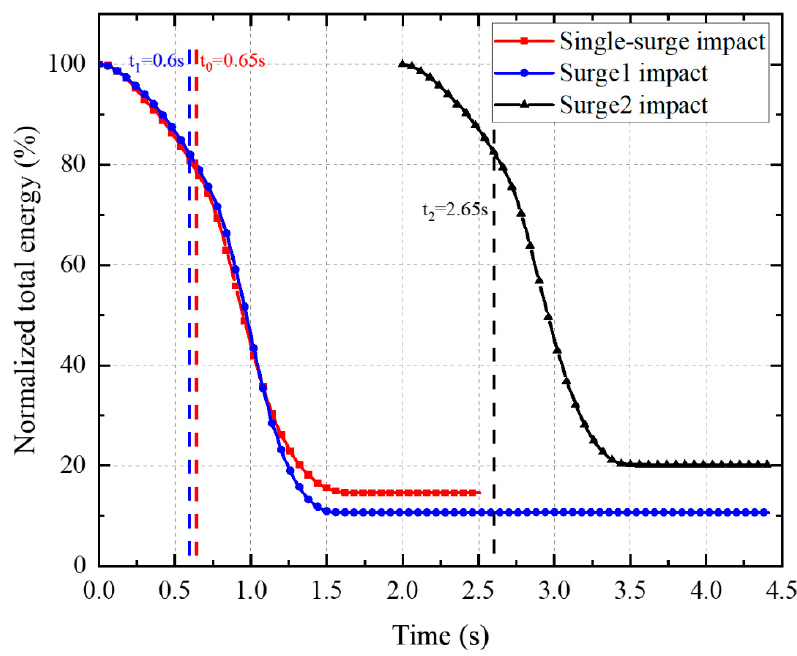
and penetration at the interaction face between surge2 and the dead zone ( 𝐸 ∆(cid:3020)(cid:2869)(cid:2879)(cid:2870) ) account for 1.94%. Figure 7. Normalized total energy of the debris surge with a slope angle of 40 ◦ and surge volume of 39.6 L. The vertical dashed lines mark critical times of the flow front. t 0 and t 1 are the time the flow fronts reach the barrier, while t 2 is the time when surge2 arrives at the dead zone formed by surge1.